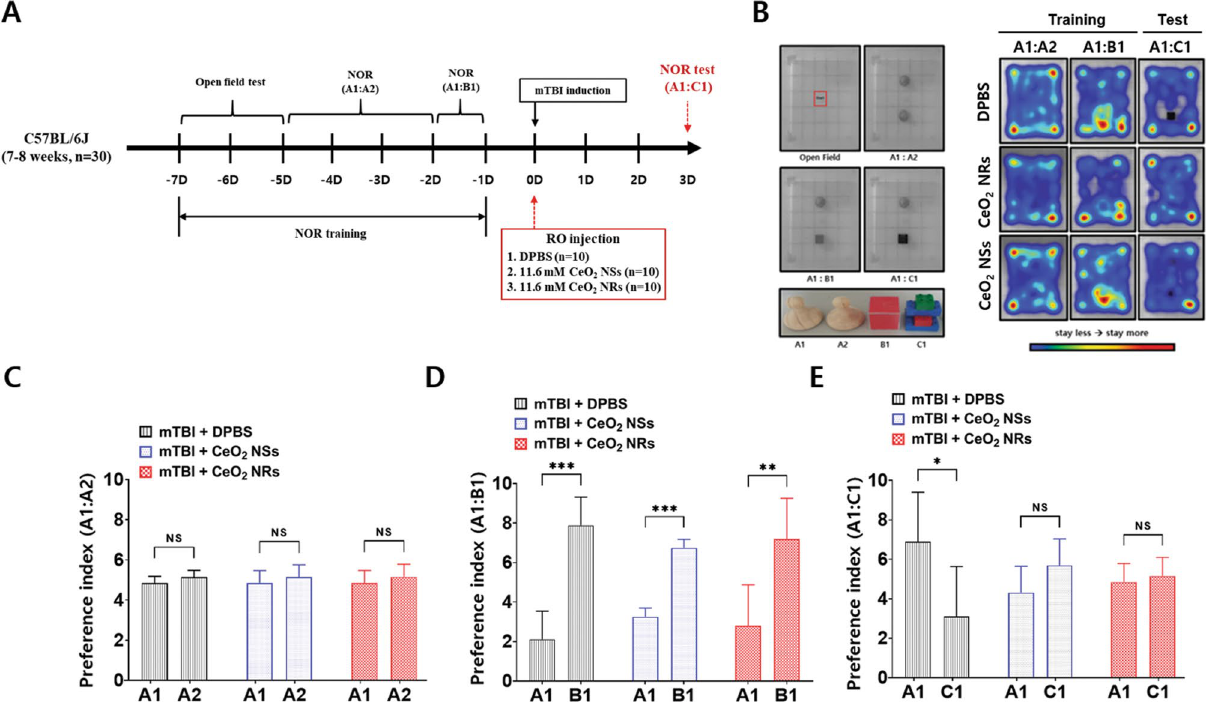
Figure 4. Experimental design of the Novel Object Recognition (NOR) test ( A ). Altered object exploration ration in the NOR test. Heat map analysis of animal tracking following NOR test ( B ). Each group shows similar preferential investigation of the novel objects before mTBI ( C , D ). Differences in the degree of impaired discrimination index following mTBI between DPBS and Ceria NSs or Ceria NRs ( E ). Mice treated with cerium oxide nanoparticles showed better preference for novel objects than DPBS, indicating cognitive improvement after injury.